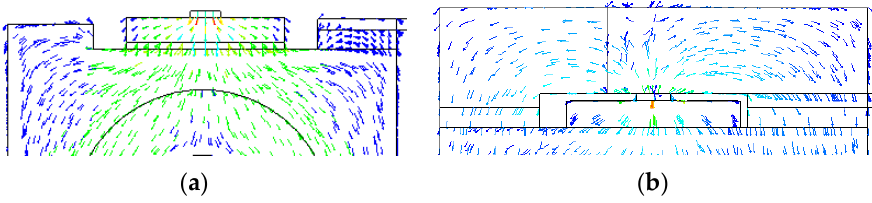
Figure 7. C-type and DC-type package temperature vector diagrams. ( a ) C-type package temperature vector diagram and ( b ) DC-type package temperature vector diagram.